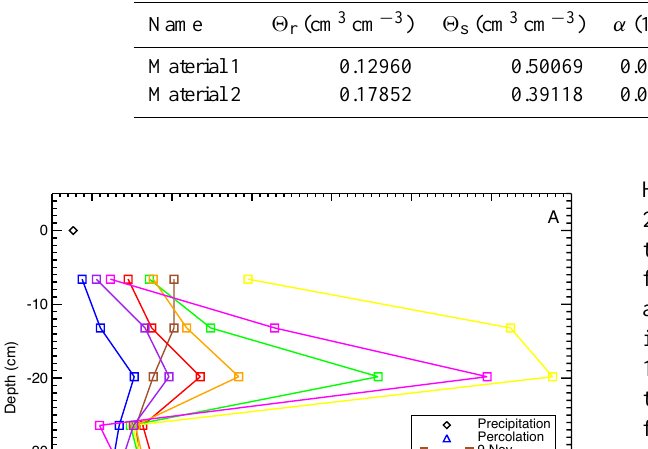
Table 1. The calibrated parameters from HYDRUS-1D inverse modeling ( 2 r is the residual water content, 2 s saturated water content, α and n parameters describing the shape of soil water retention curve and hydraulic conductivity curve, K s saturated hydraulic conductivity and I pore-conductivity).